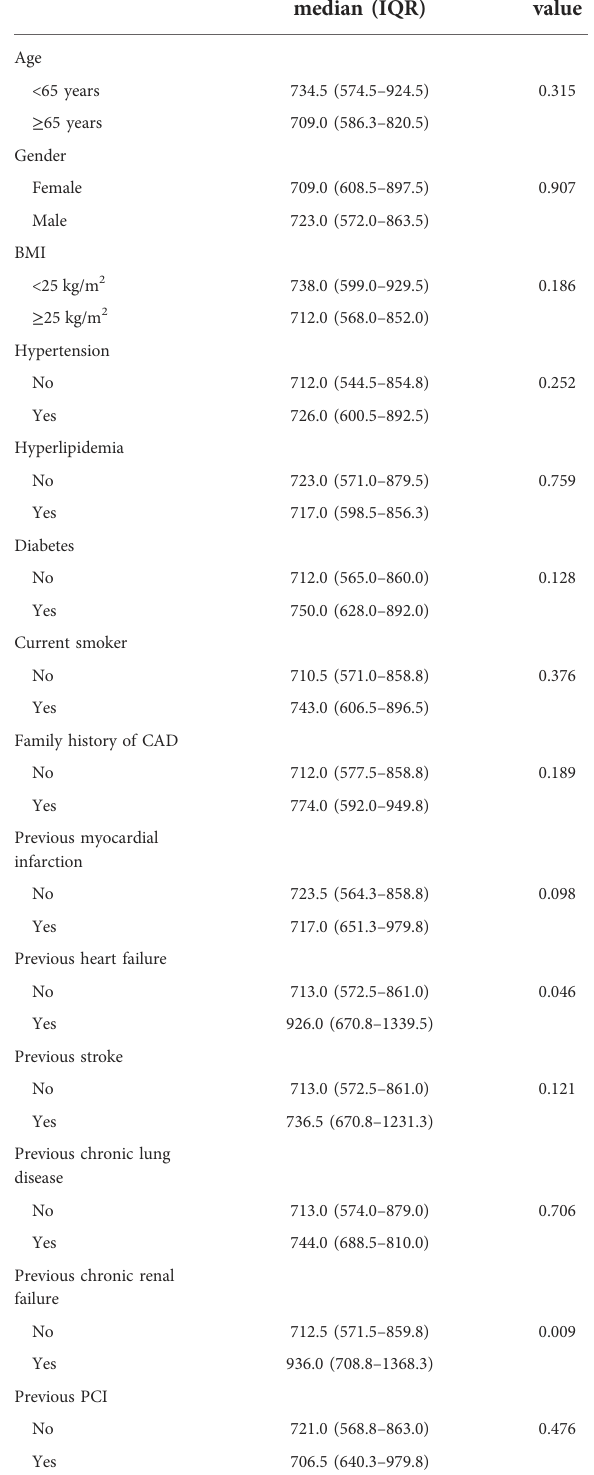
TABLE 2 Comparison of FGF-23 level in patients with different clinical